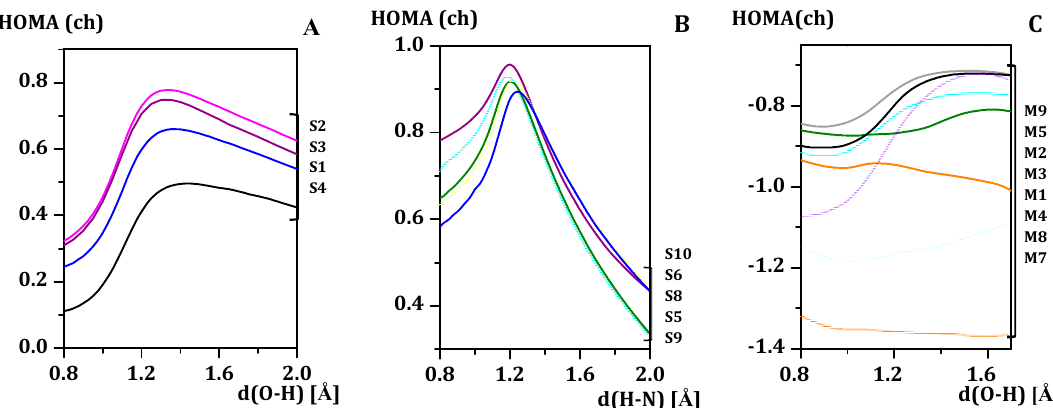
Figure 5. The dependencies of the aromaticity index of the chelate ring (HOMA(ch)) on the OH or HN bond lengths (d(OH/HN), in [Å]) for aryl ( I , chart A ) and alkyl Schiff bases ( II , chart B ), as well as Mannich bases ( III , chart C ). Ref. [29]—Reproduced by permission of The Royal Society of Chemistry.